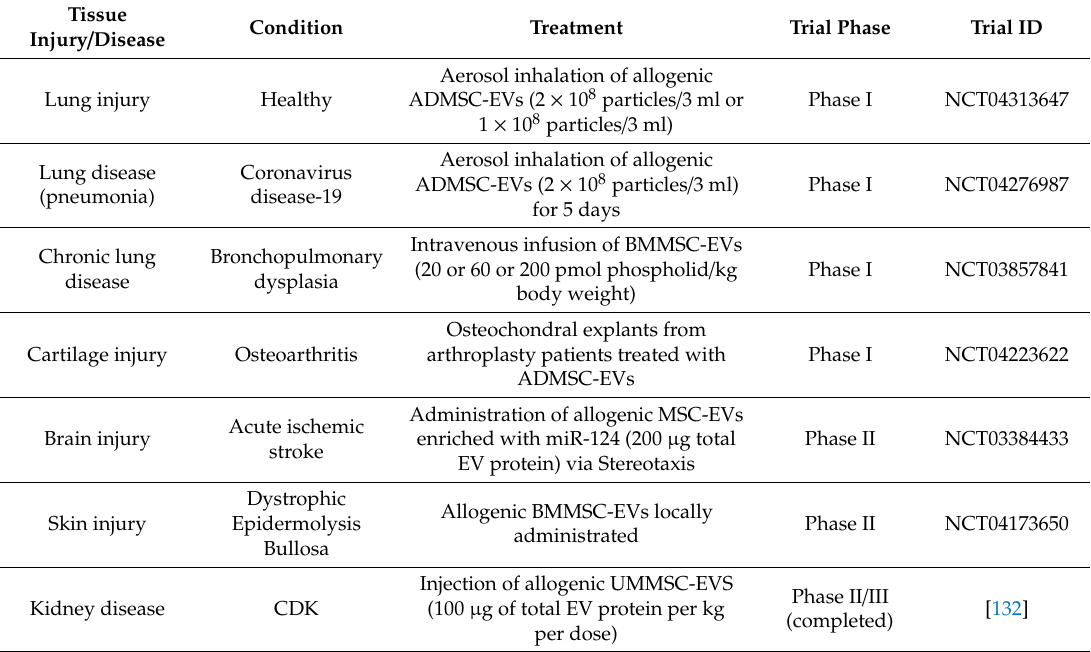
Table 2. List of clinical trials using MSC-EVs against tissue injuries